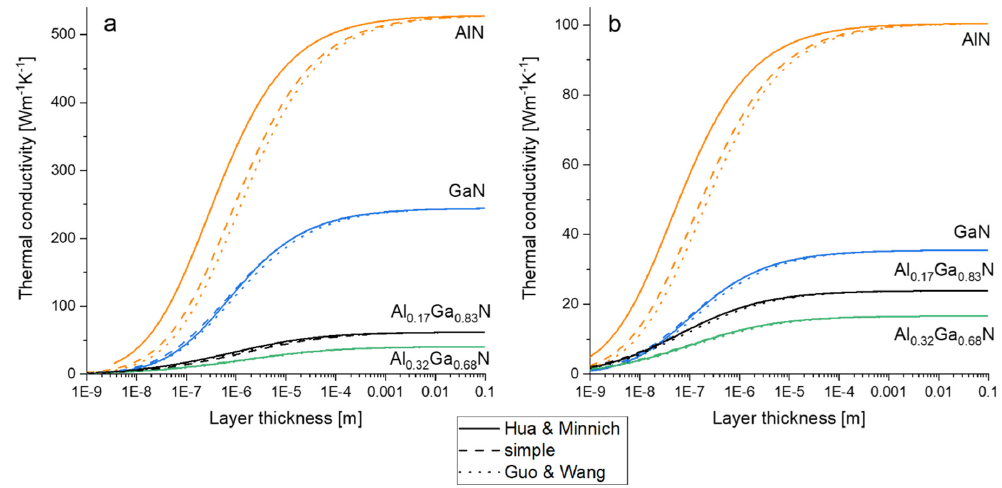
Figure 7. The size-dependent thermal conductivity for AlN (orange), GaN (blue), Al 0.32 Ga 0.68 N (green) and Al 0.17 Ga 0.83 N (black) at ( a ) 300 K and ( b ) 773 K. The size-dependent thermal conductivity evaluated within the framework of the BvK transport model. The Hua–Minnich approach is drawn as solid lines, the simple boundary scattering approach as dashed lines, and the approach of Guo and Wang as dotted lines.